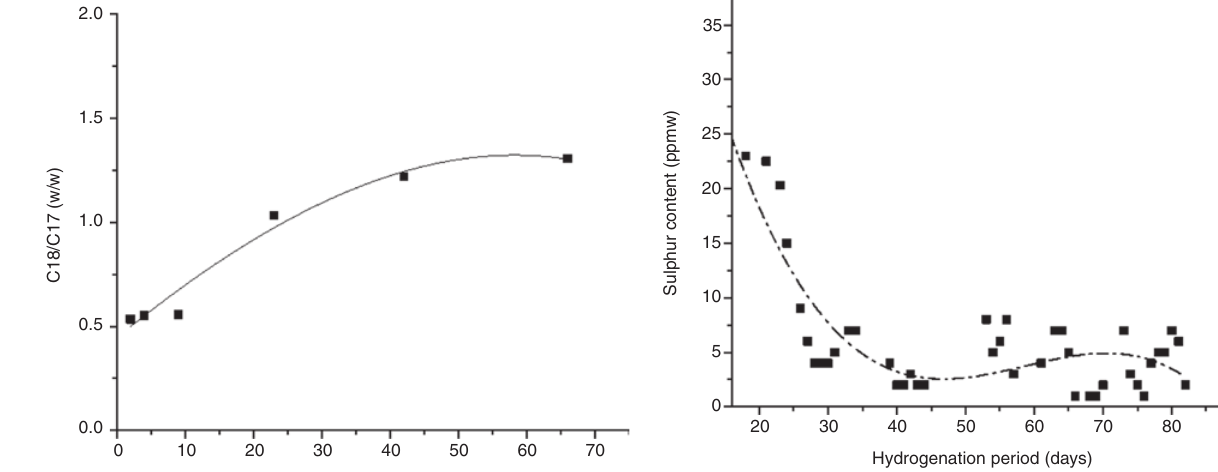
acid methyl ester (FAME) with light gas oil (LGO) at 360 ° C with liquid hourly space velocity (LHSV) = 1 1/h and P = 5